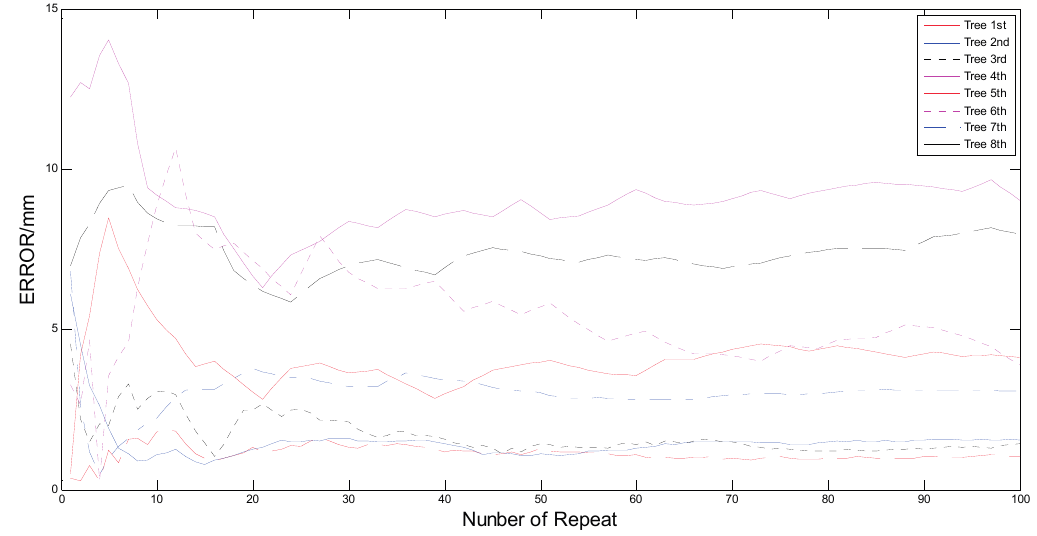
Figure 10. The relationship between the number of repeat and the absolute error of diameter estimation for all